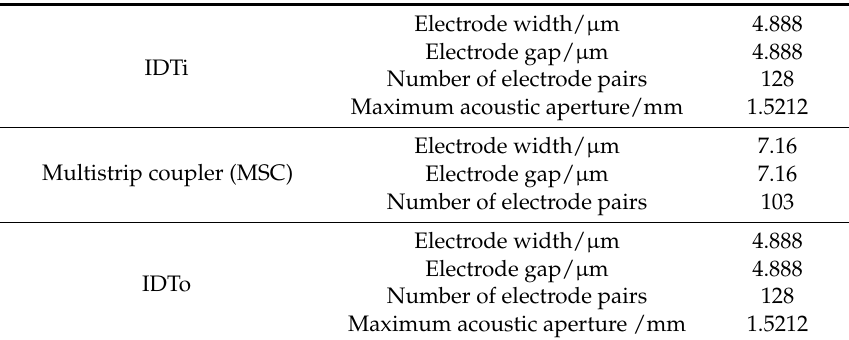
Table 1. Design parameters of the Love device.